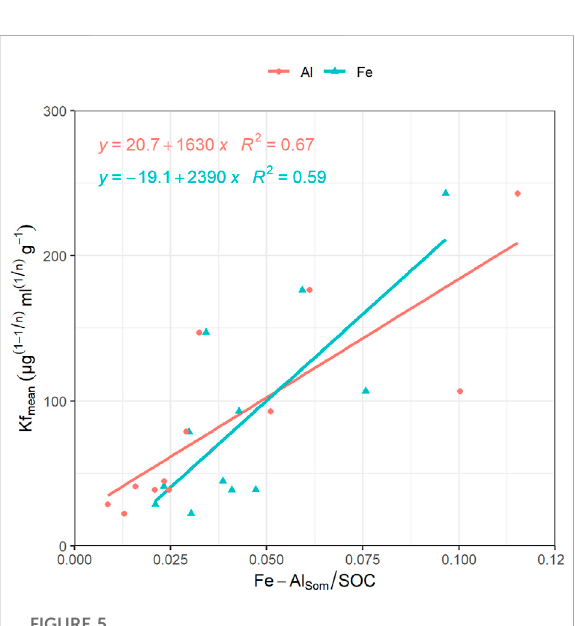
FIGURE 5 Regression lines with coef fi cient of determination between Al Som /SOC (orange dots) and K f-mean and between Fe Som /SOC (blue triangles) and K f-mean